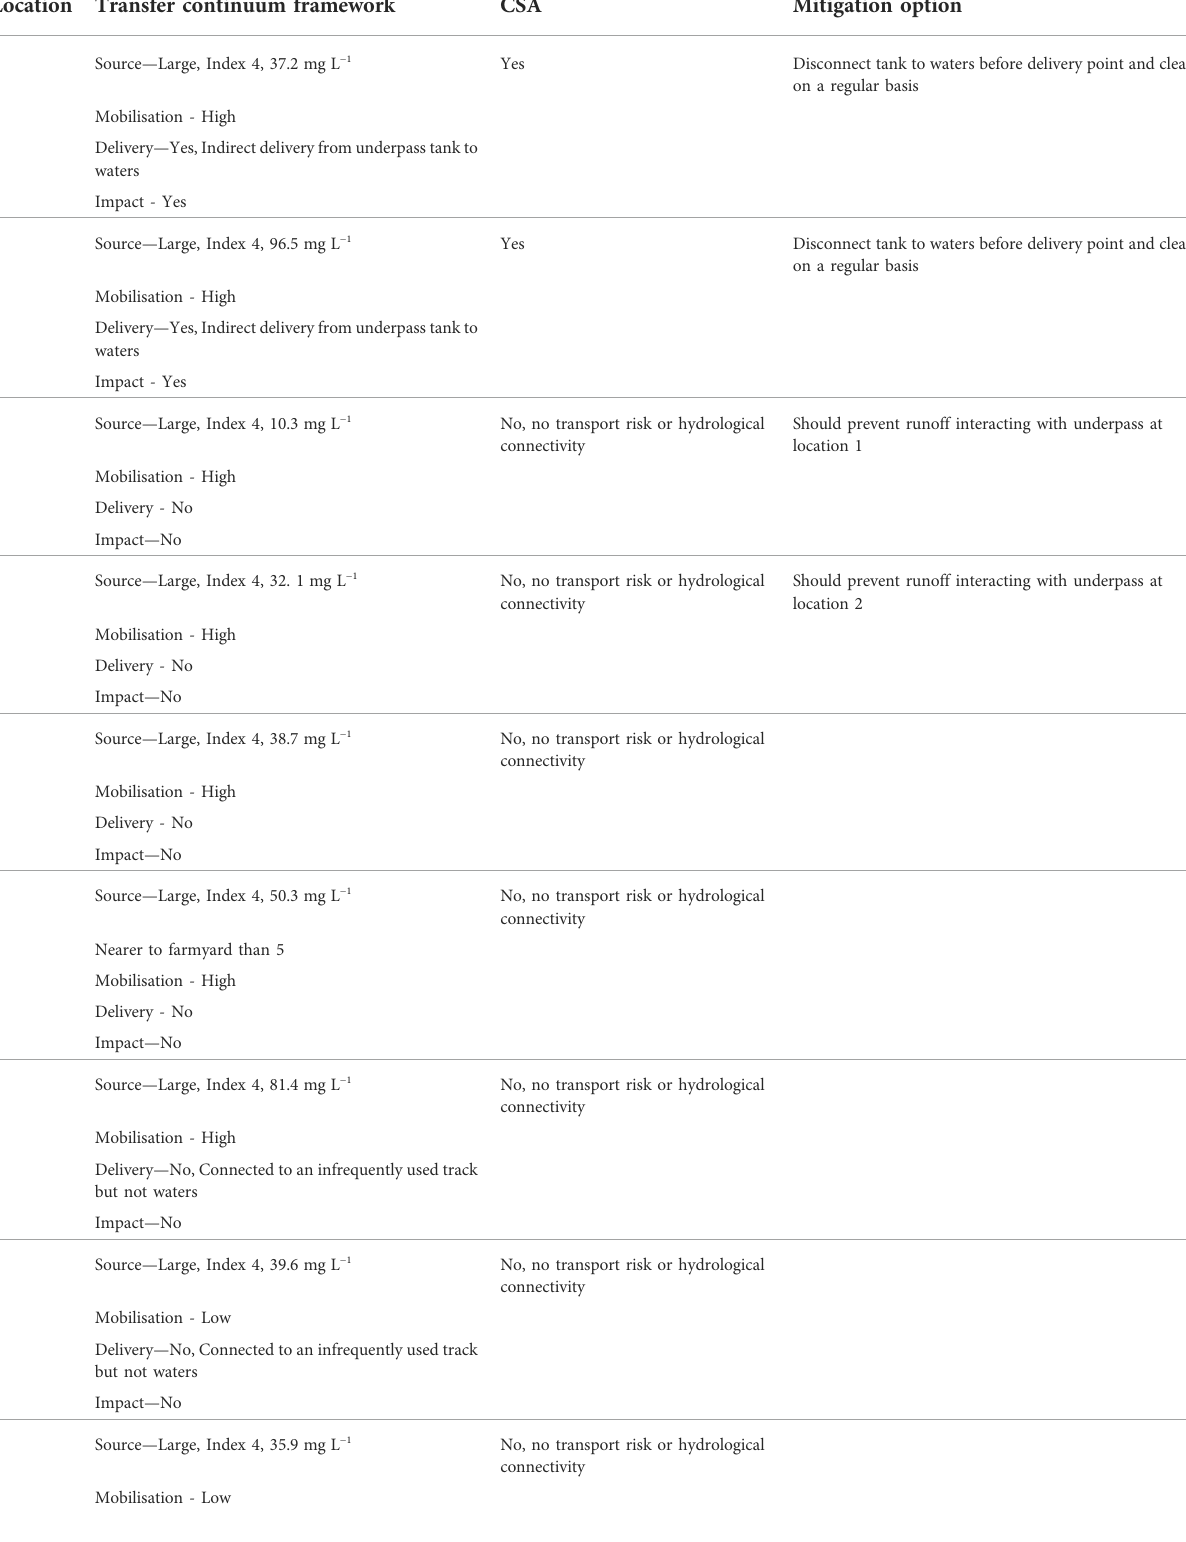
TABLE4PhosphoruscomponentofNutrientTransferContinuumFrameworkforeachlocation,CriticalSourceArea(CSA)andMitigationOptions.All concentrations refer to Morgan ’ s